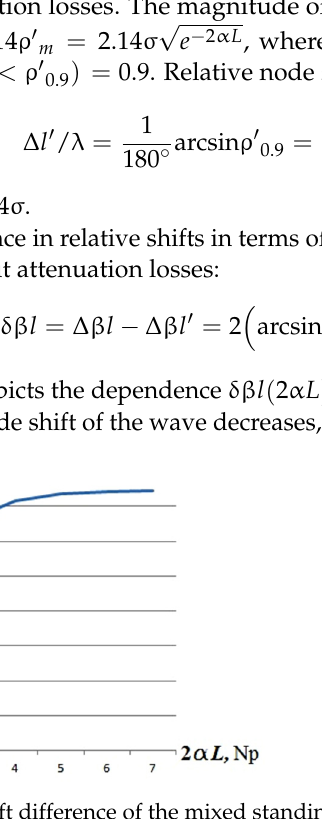
Figure 6. Note shift difference of the mixed standing and travelling wave.